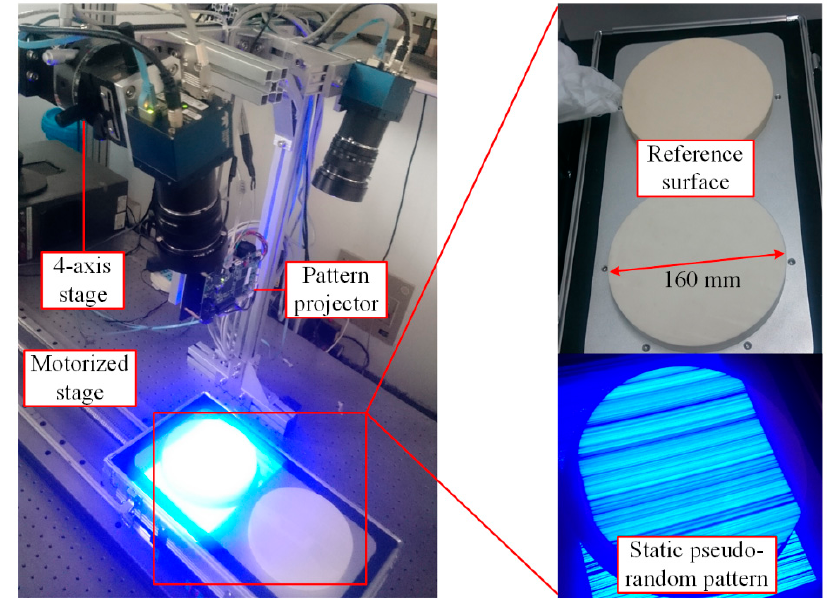
Figure 9. Experimental setup for verifying the sensor.